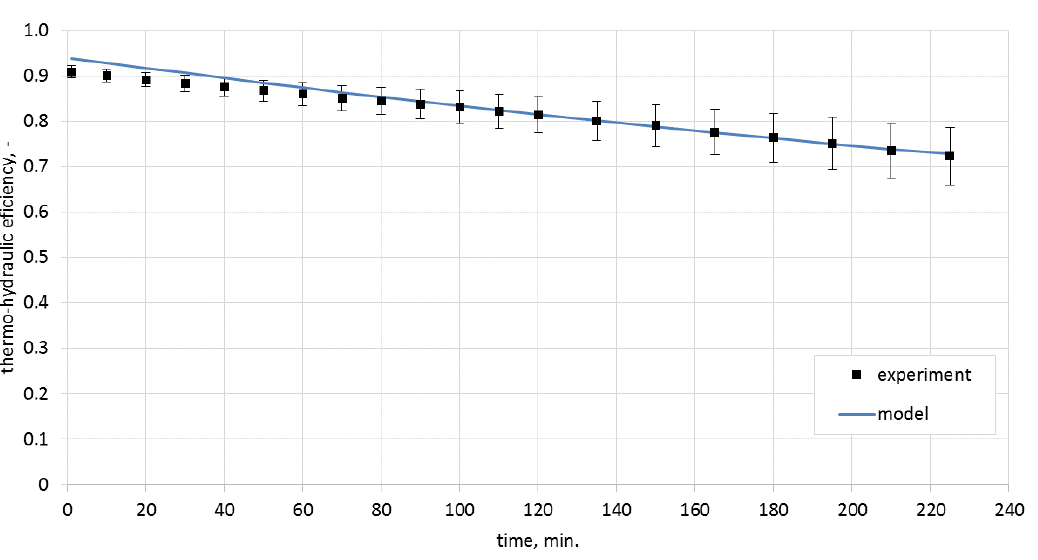
Figure 10. Thermo-hydraulic efficiency as a function of the difference between the inlet temperature and ceramic brick temperature. In order to estimate the influence of airflow rate on the efficiency of the process, the model was used to calculate the characteristics for four inlet temperatures as a function of airflow rate and various ceramic brick temperatures (Figures 11–14).